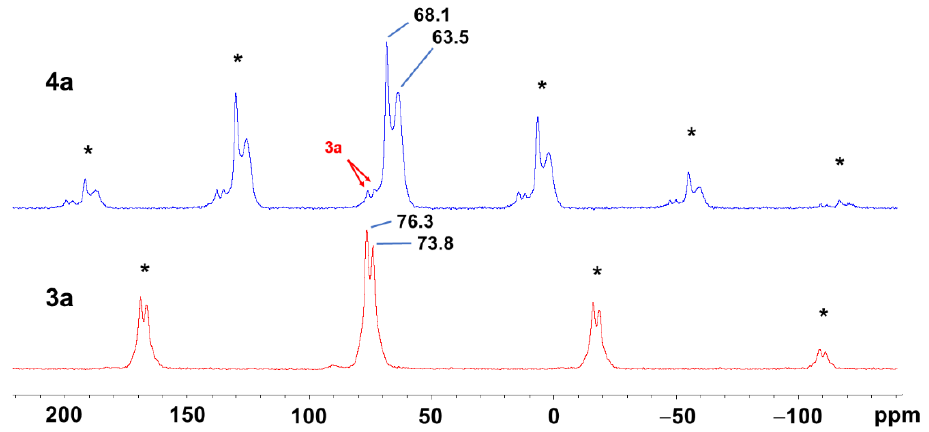
Figure 7. 31 P CP/MAS NMR spectra of 3a (bottom) and 4a (top) recorded at spinning frequencies of 15 kHz and 10 kHz, respectively. (The chemical shifts are given for the isotropic signals. The asterisked signals are spinning sidebands).